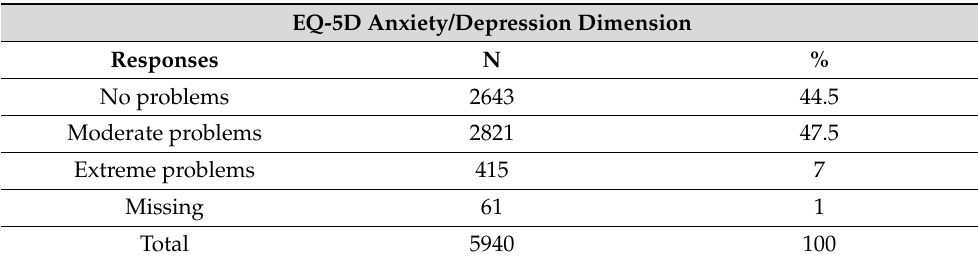
Table 2. Statistics of EQ-5D descriptive system (anxiety/depression